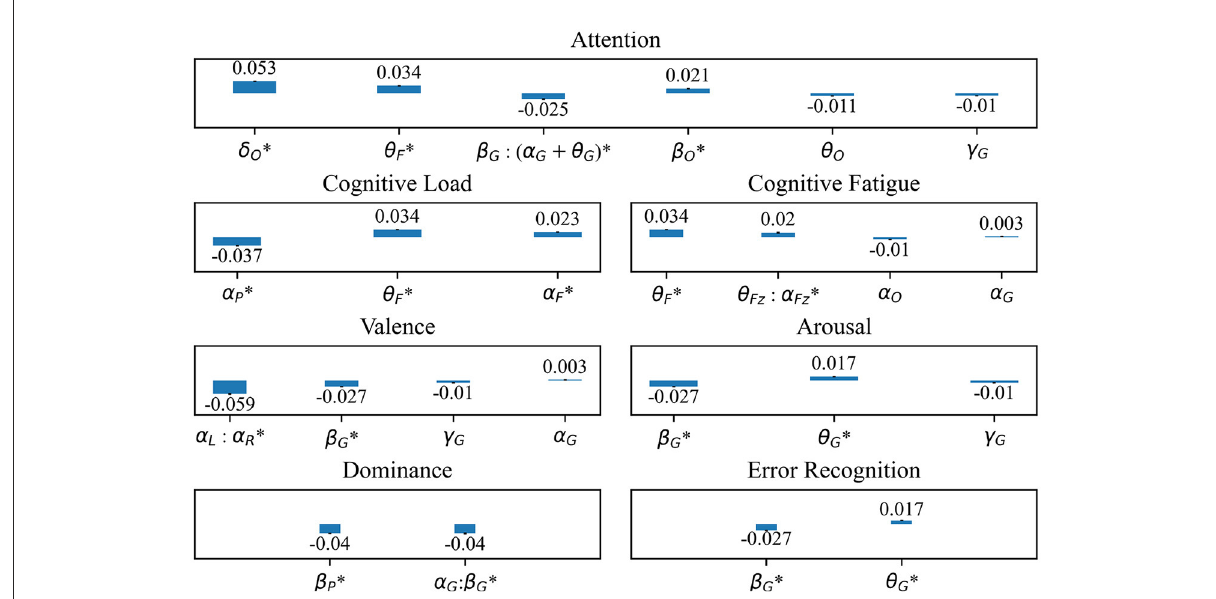
FIGURE5 Standardized fixed effect estimates of intraoperative error on previously studied EEG correlates of cognitive and affective features including Attention, Cognitive Load, Cognitive Fatigue, Valence, Arousal, Dominance, and Error Recognition. Electrode regions include O, occipital; F, frontal; G, global; P, parietal; L, left hemisphere; R, right hemisphere. *: Fixed effect estimate meets significance threshold of P = 0.00009. All fixed effect estimates are standardized.